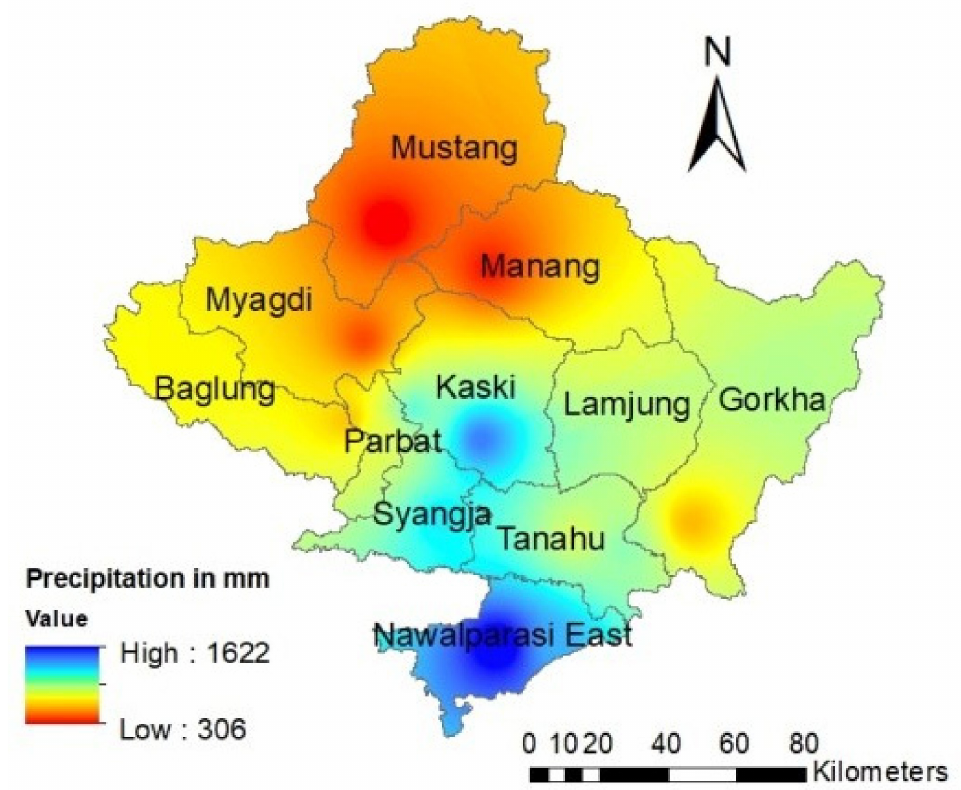
Figure 10. Annual 3-day extreme precipitation for 100-year return periods from the MRI-ESM2-0 model for the far